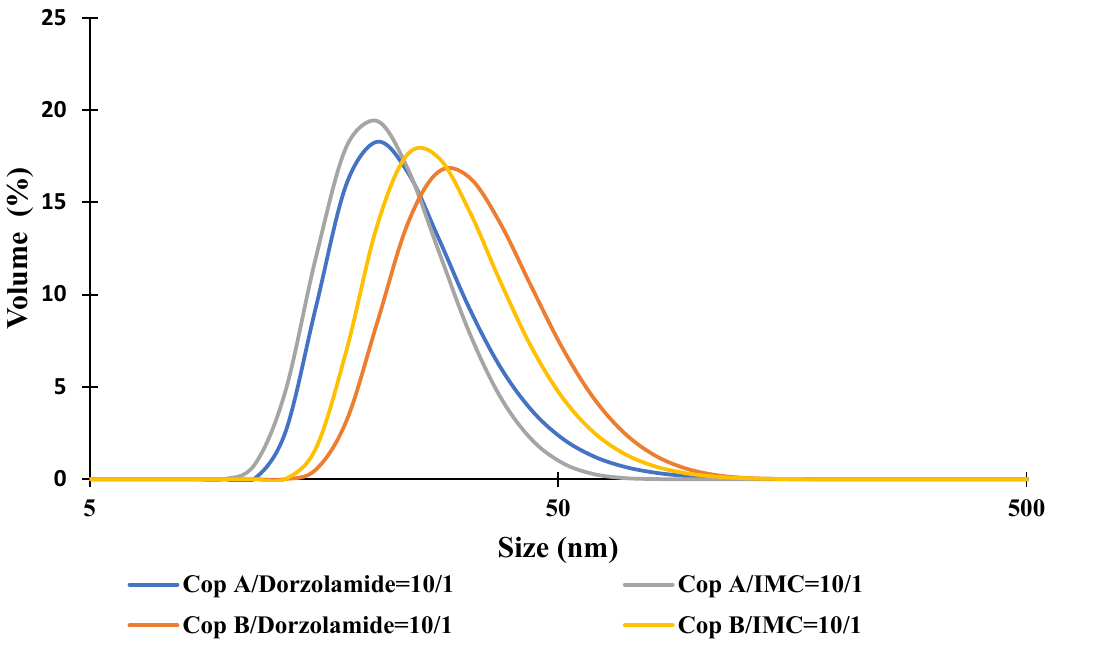
Figure 1. Size distribution curves for drug-loaded PMs at a copolymer/drug ratio of 10/1.